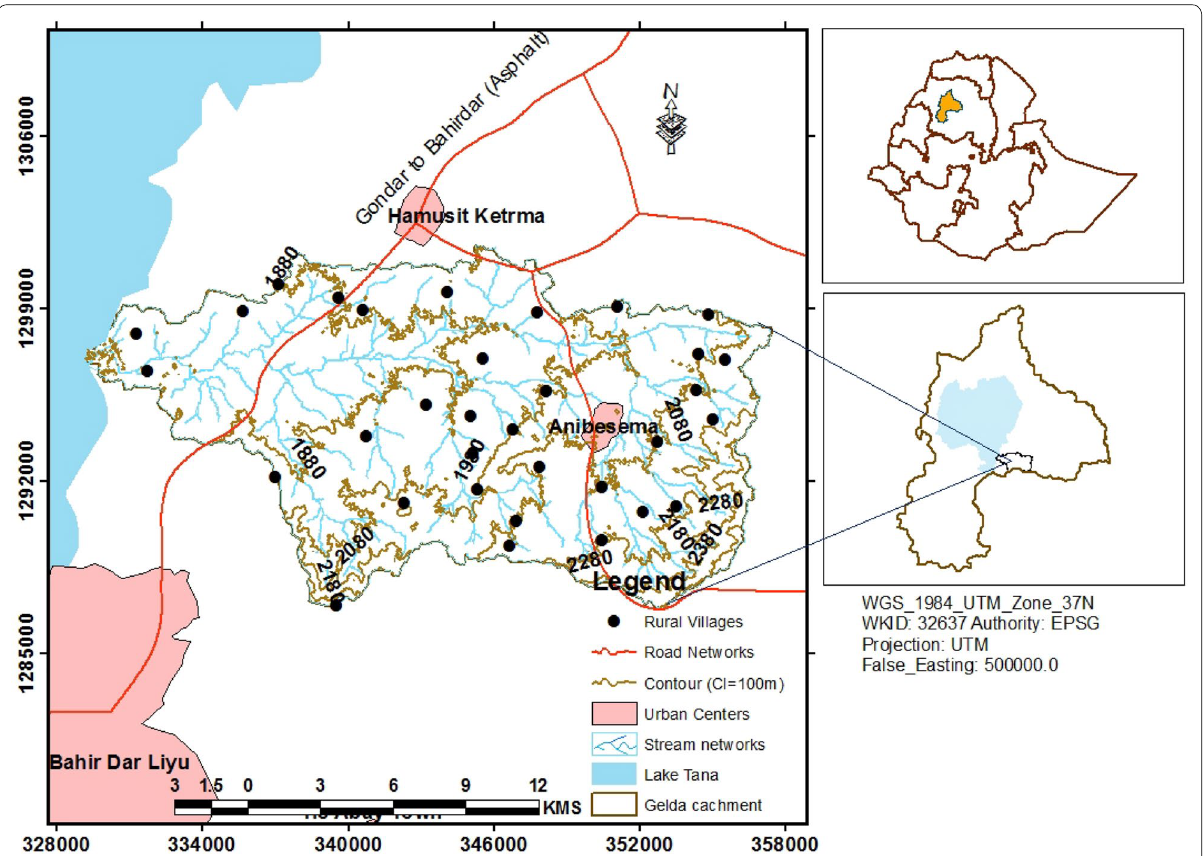
Fig. 1 Location map of Gelda catchment, Northwestern highlands of